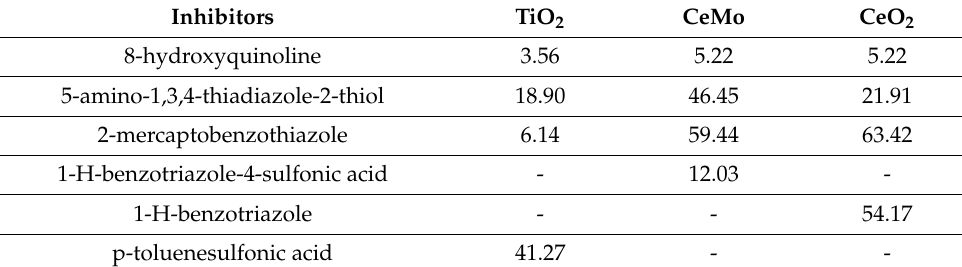
Table 2. Inhibitor loading in the nanocontainers (Adapted with permission from Reference [148]).